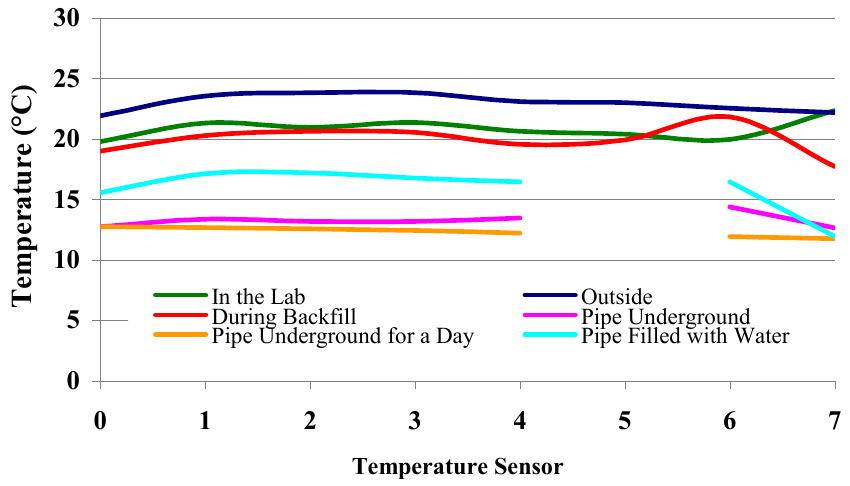
Figure 11. Temperature data collected from the various temperature sensors along the pipe when exposed to different